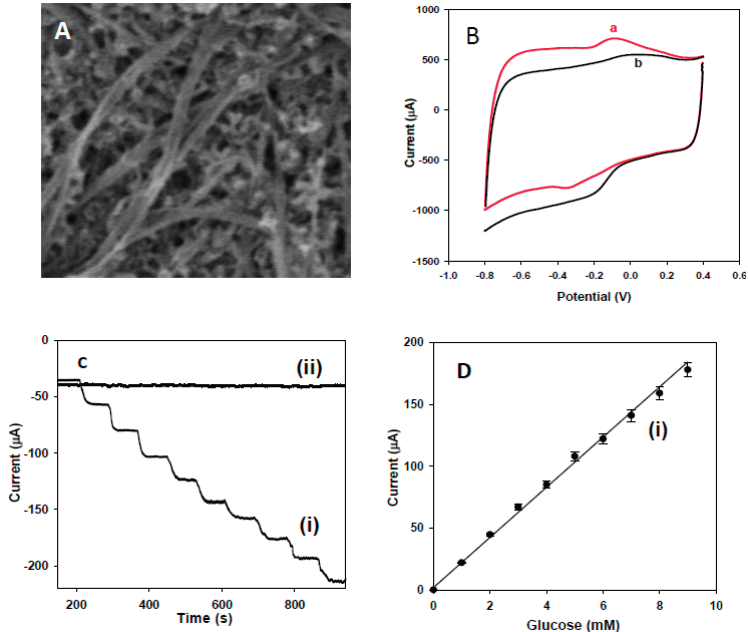
Figure 7. ( A ) FE-SEM images of the carbon-buckypaper. ( B )